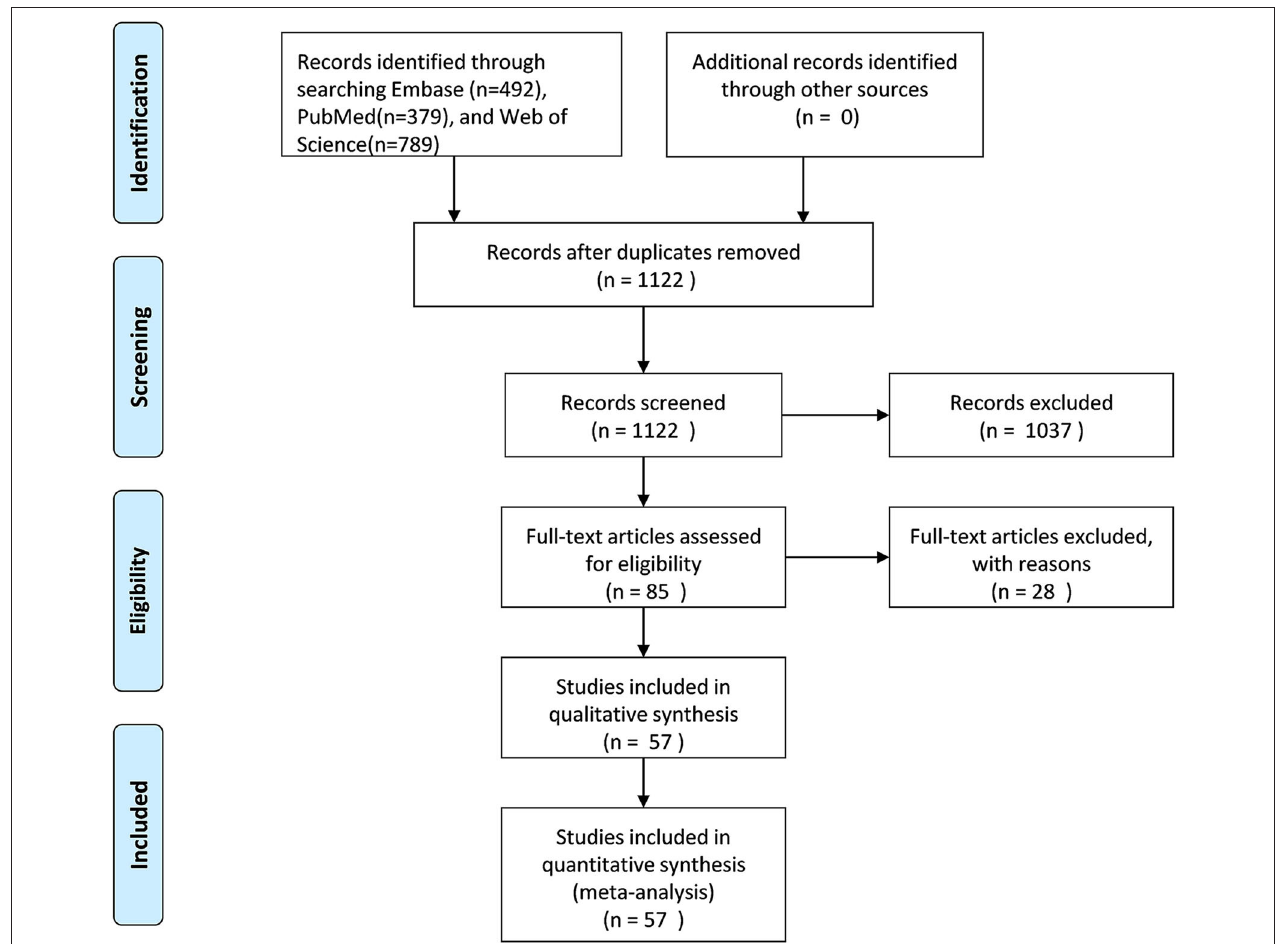
FIGURE 1 | Flow graph of study search and